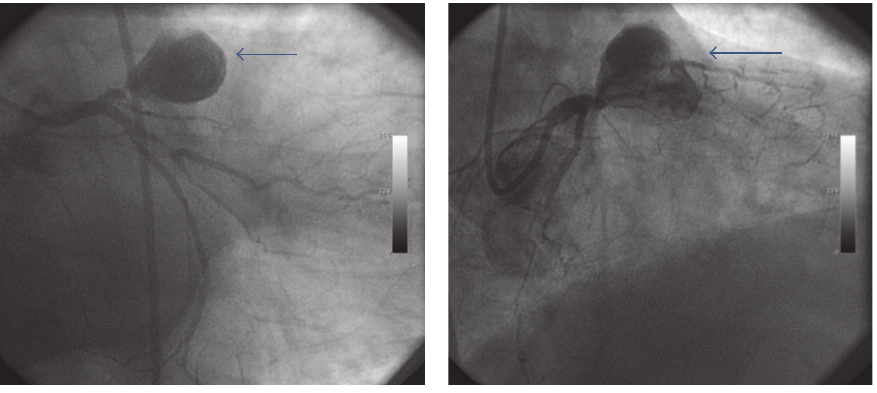
Figure 1: Huge coronary artery aneurysm (32 × 26 mm) in the left anterior descending (LAD) artery. Please note that no flow is present distal to the